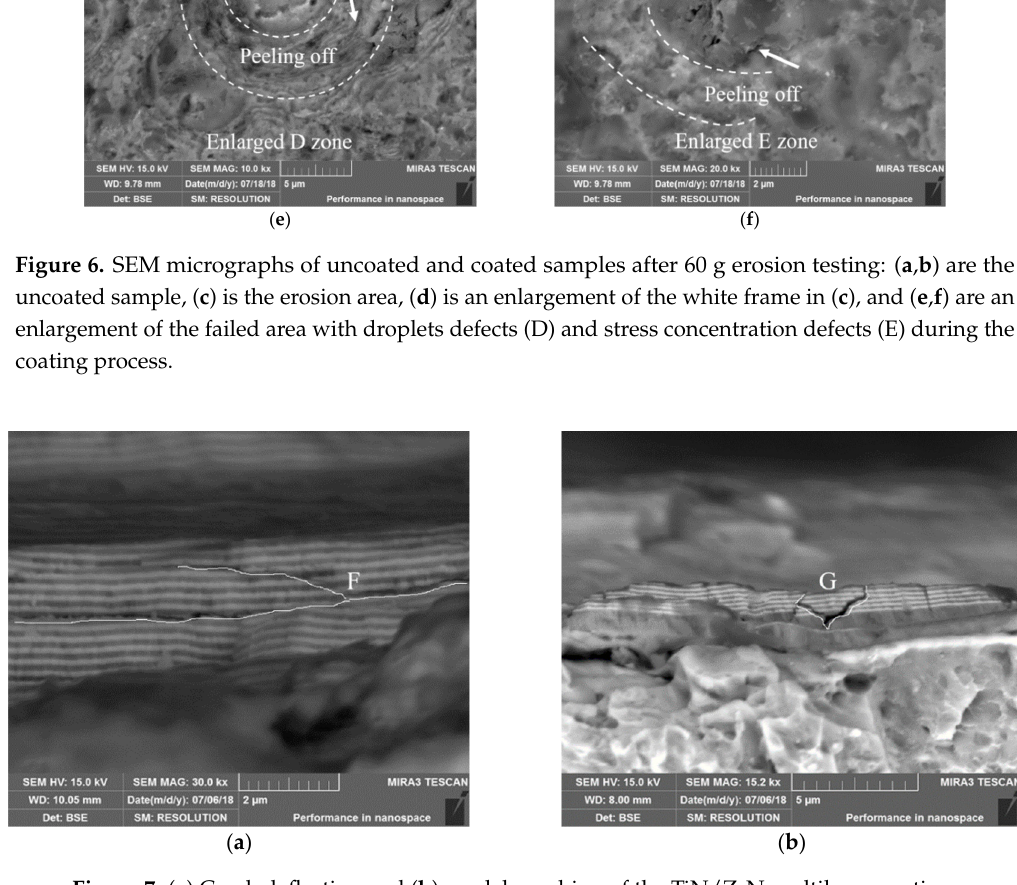
Figure 7. ( a ) Crack deflection and ( b ) crack branching of the TiN/ZrN multilayer